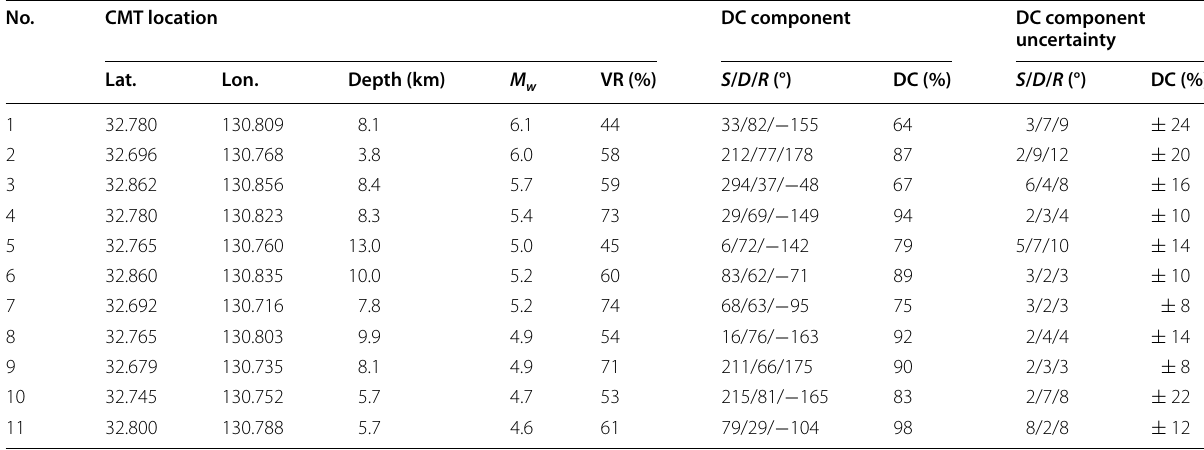
VR variance reduction, M w moment magnitude, S/D/R strike/dip/rake